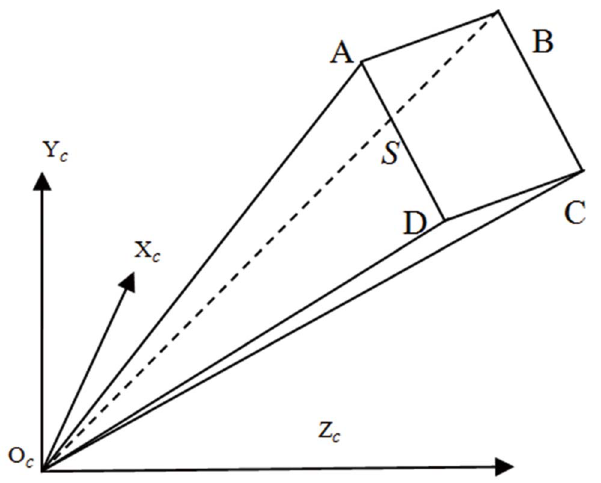
Figure 8. Determination the normal